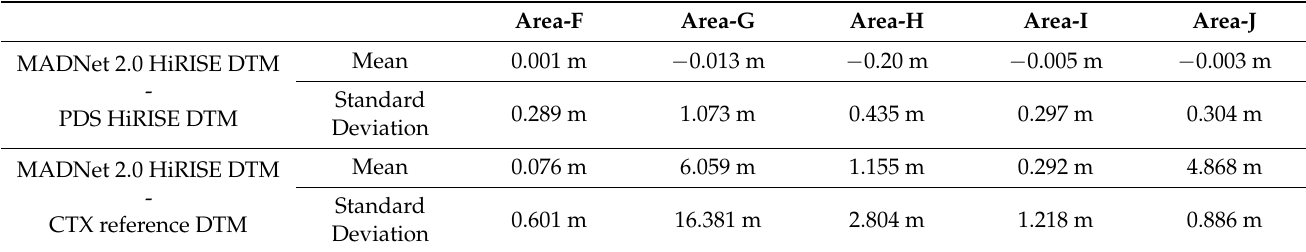
Figure 25. DTM profile measurements of the 1 m/pixel PDS HiRISE DTM, the 25 cm/pixel MADNet 2.0 DTM, and the 12 m/pixel MADNet 1.0 CTX DTMs (the reference DTM) for area-J (location is shown in Figure 10). N.B. all profile measurements begin from the labelled side of the profiles lines that are shown on the image and DTMs to the other end of the lines. Table 3. Statistics (mean and standard deviations) of the DTM difference maps that are shown in Figure